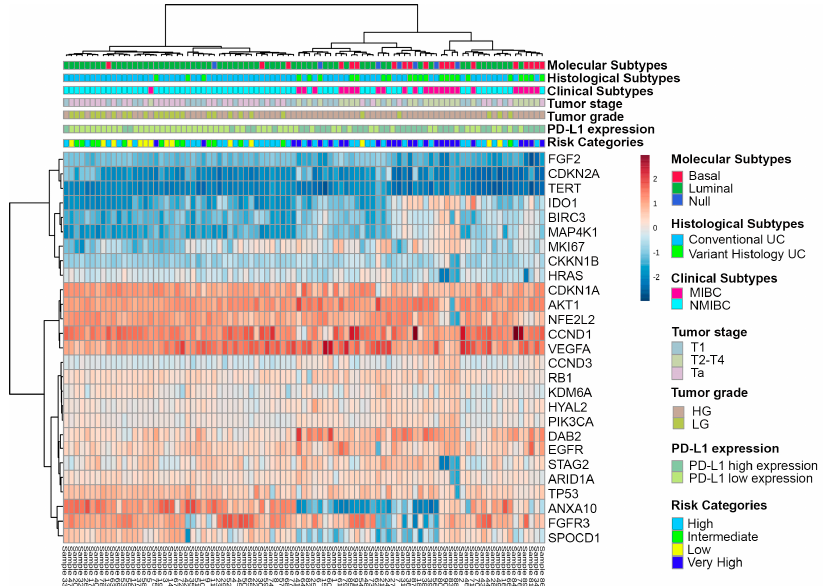
Figure 2. Heat map showing the gene expression level grouped as molecular, histological, and clinical subtypes, as tumor-stage category, tumor grade, PD-L1 expression, and clinical risk categories of urothelial carcinoma.